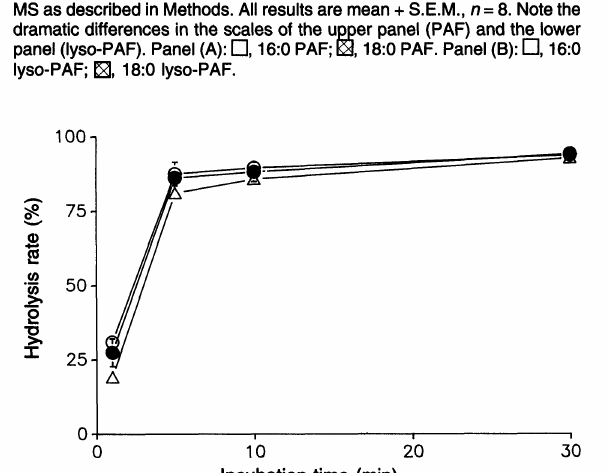
FIG. 2. The rate of PAF hydrolysis to lyso-PAF of incubation media obtained from incubations containing intestinal tissue before ischaemia, after 3 h ischaemia, and after reperfusion. Nonspecific PAF hydrolysis, calculated from the hydrolysis of PAF in media without intestinal tissue, was less than 5% and has been subtracted from the rates shown for intestinal tissue, n 8, Key: (O), before ischaemia; (o), ischaemia; (/k),